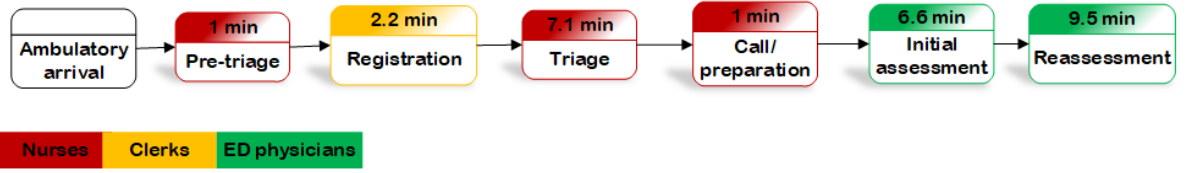
Figure 1. Process mapping for upper respiratory tract infections in the emergency department (truncated). Each box represents a process with its duration. Colors identify human resources (red=nurses; yellow=clerks; green=physicians). ED: emergency